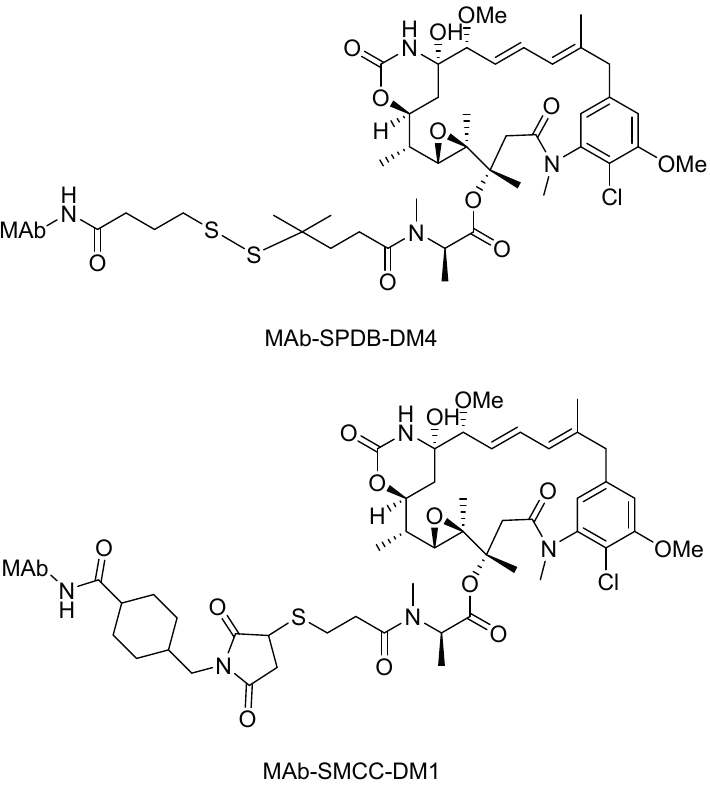
Figure 6. The structural formulas of huC242-SPDB-DM4 and huC242-SMCC-DM1. Adapted from Reference